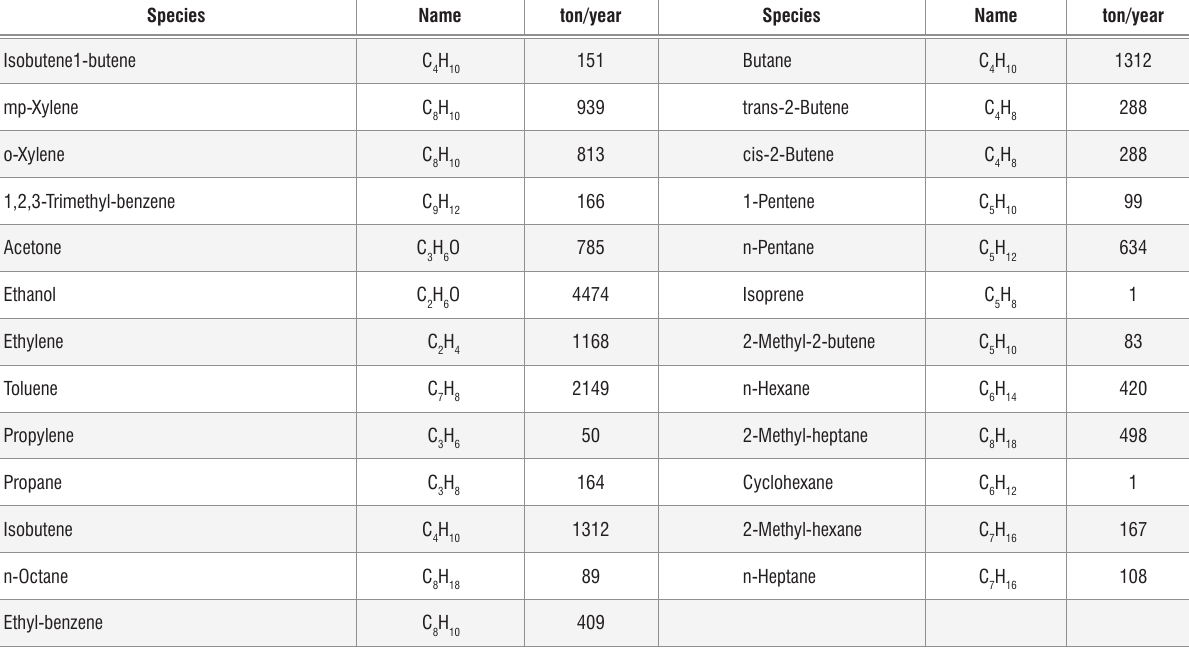
required that the emissions of NO and NO species were separated. 2 Various factors influence the NO/NO ratio from raw exhaust gas, 2 e.g. petrol or diesel engines, or exhaust gas from diesel engines after processing by a catalytic converter. 31 The NO fraction in NOx varies 2 between 5% and 25% by mass, depending on the type of vehicle and fuel. 31 The European Monitoring and Evaluation Programme (EMEP) of the European Environmental Agency (EAA) compiled an air pollution emission inventory guidebook (EMEP/EEA), which provides guidance on estimating emissions from both anthropogenic or natural emission sources. 32 Based on the EMEP/EAA guidebook, it was assumed in the model that the NO/NO ratio for raw exhaust gas vehicle emissions was 2 80% NO and 20% mass fraction NO . 2 The Euro fuel specification is defined as the acceptable limits for exhaust emissions of new vehicles in Europe in order to meet their stringent emission regulations. The ‘criteria’ atmospheric pollutants are regulated through these standards. South Africa has also adopted this standard classification reference method. The different Euro specifications are an indication of when they came into force, i.e. Euro-0, pre-1993; Euro-1 in 1993; Euro-2 in 1996; Euro-3 in 2000, Euro-4 in 2005 and Euro-6 in 2014. According to Goyns 29 , the private passenger vehicle fleet in the Jhb-Pta megacity from 2001 to 2005 consisted of approximately 45% Euro-0 type petrol vehicles, 10% Euro-2 diesel vehicles, 30% Euro-2 petrol vehicles and 15% Euro-3 petrol vehicles. The percentages of each pollutant species emitted from the different Euro classified vehicles that was used in this study are listed in Table 3.